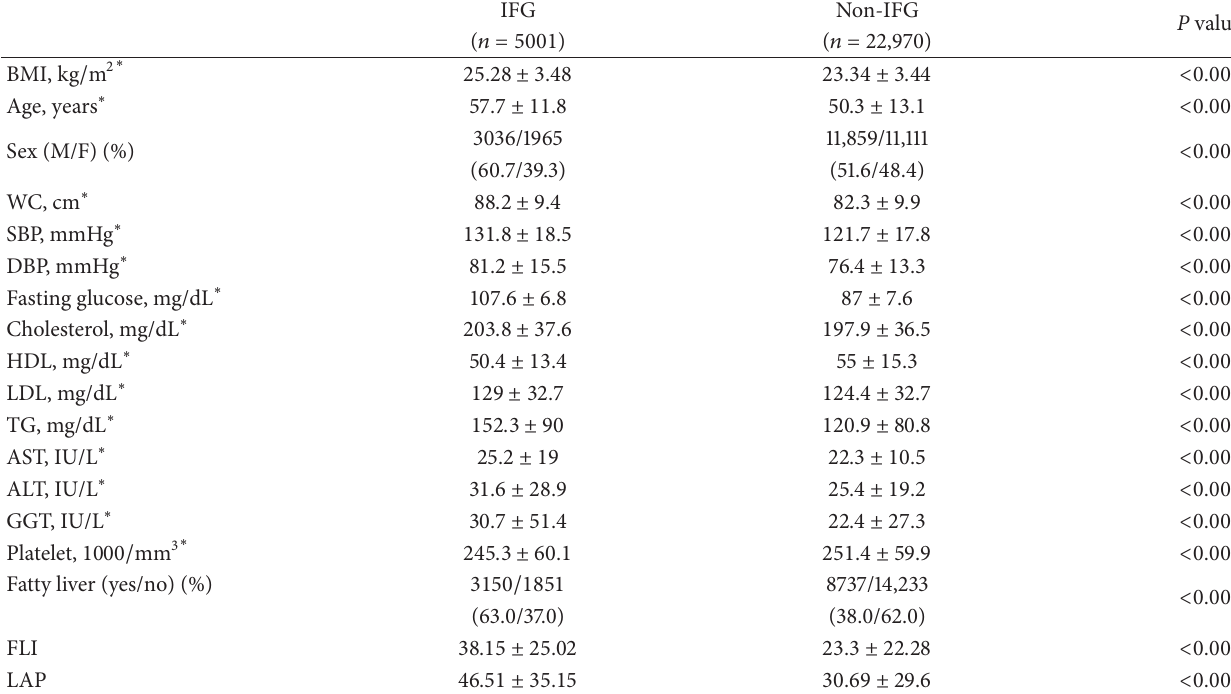
Table 4: Characteristics of subjects with IFG.